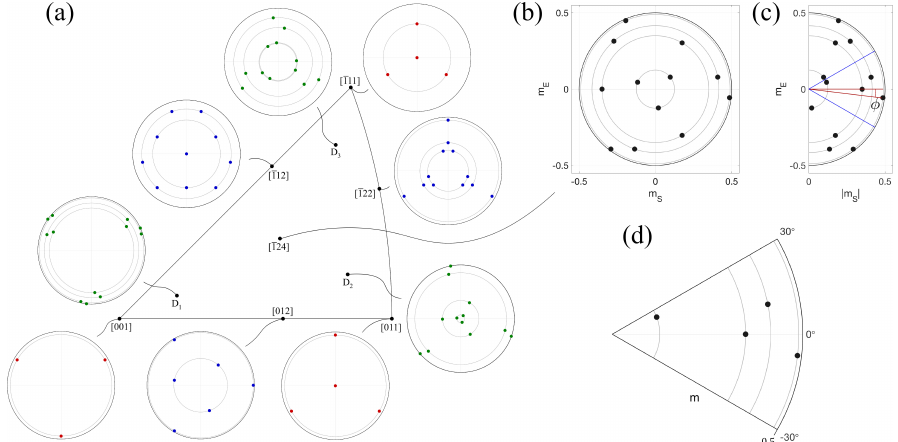
Figure 2. ( a ) Fundamental sector of an fcc unit cell with maps of the Schmid and Escaig factors of the (cid:104) 110 (cid:105){ 111 } slip systems for multiple orientations of uniaxial tensile loading. The maps correspond 12 a 2 to orientations at the vertices (red), at the edges (blue) and at points situated 10 ◦ away from the vertices (green). The four grey circles in each map, one for every slip plane, contain their respective three slip directions. To facilitate visualisation, the gridlines cross each other at (0,0) and the black circles have a radius of 0.5. ( b ) The map for orientation [ 124 ] is plotted separately for reference, together with its corresponding ( c ) | m S | half map and ( d ) reduced map over the domain of φ . The blue lines in ( c ) correspond to the mirror planes of the three regions in the map and the red lines show the definition of angle φ for